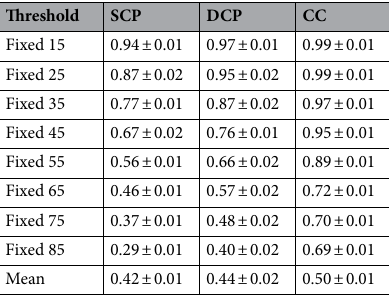
Table 1. Vessel density values depending on the fixed threshold adopted and comparison with “Mean”